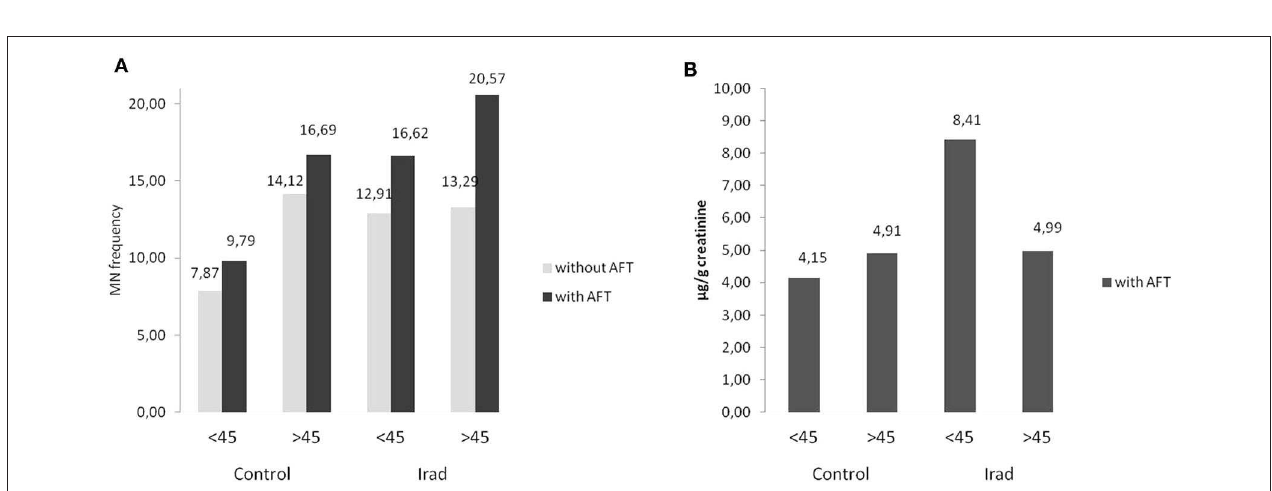
FIGURE 3 | The micronucleus frequency (A) and 8-OHdG values (B) in relation to different amounts of consumed milk with AFT in hospital workers exposed to ionizing irradiation. MN, micronucleus frequency; 8-OHdG, 8-hydroxy-2 ′ -deoxyguanosine value; *, statistically significant difference in comparison to the control group, who consumed ≤ 0.5 L/month of milk.